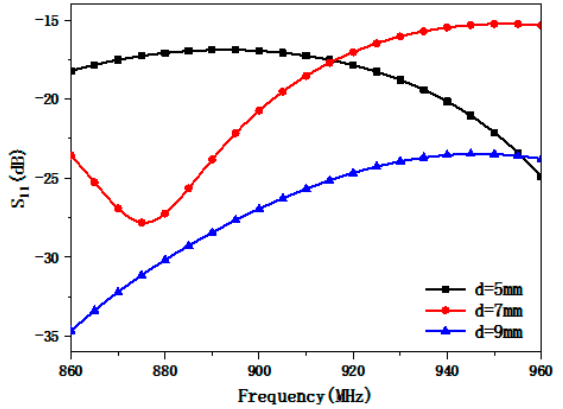
Figure 15. Simulated reflection coefficient S11 with different loop spacings in the antenna.